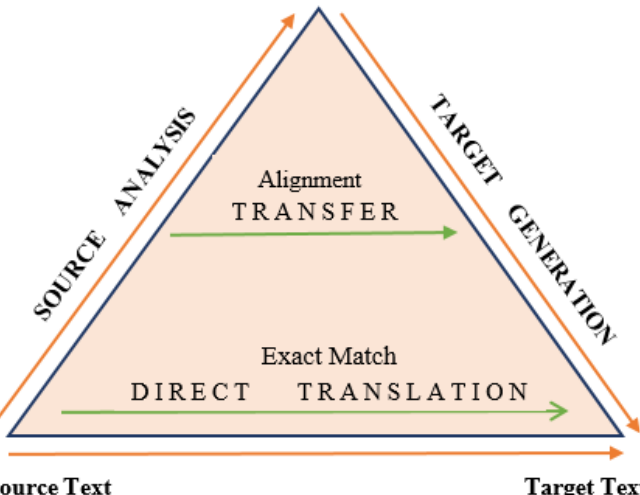
Figure 4. The “Vauquois Pyramid” adapted for EBMT